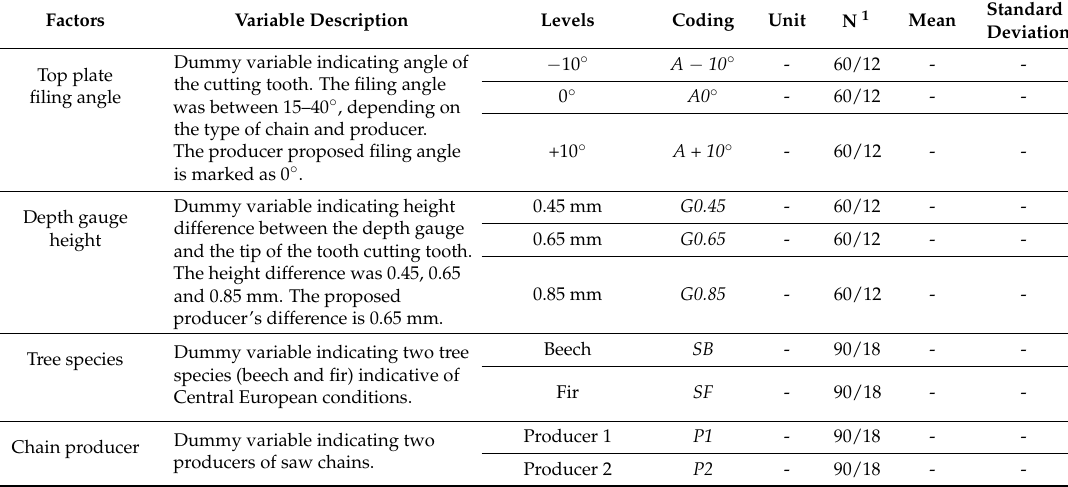
1 Sample size: cutting efficiency analyses/wood dust analyses.